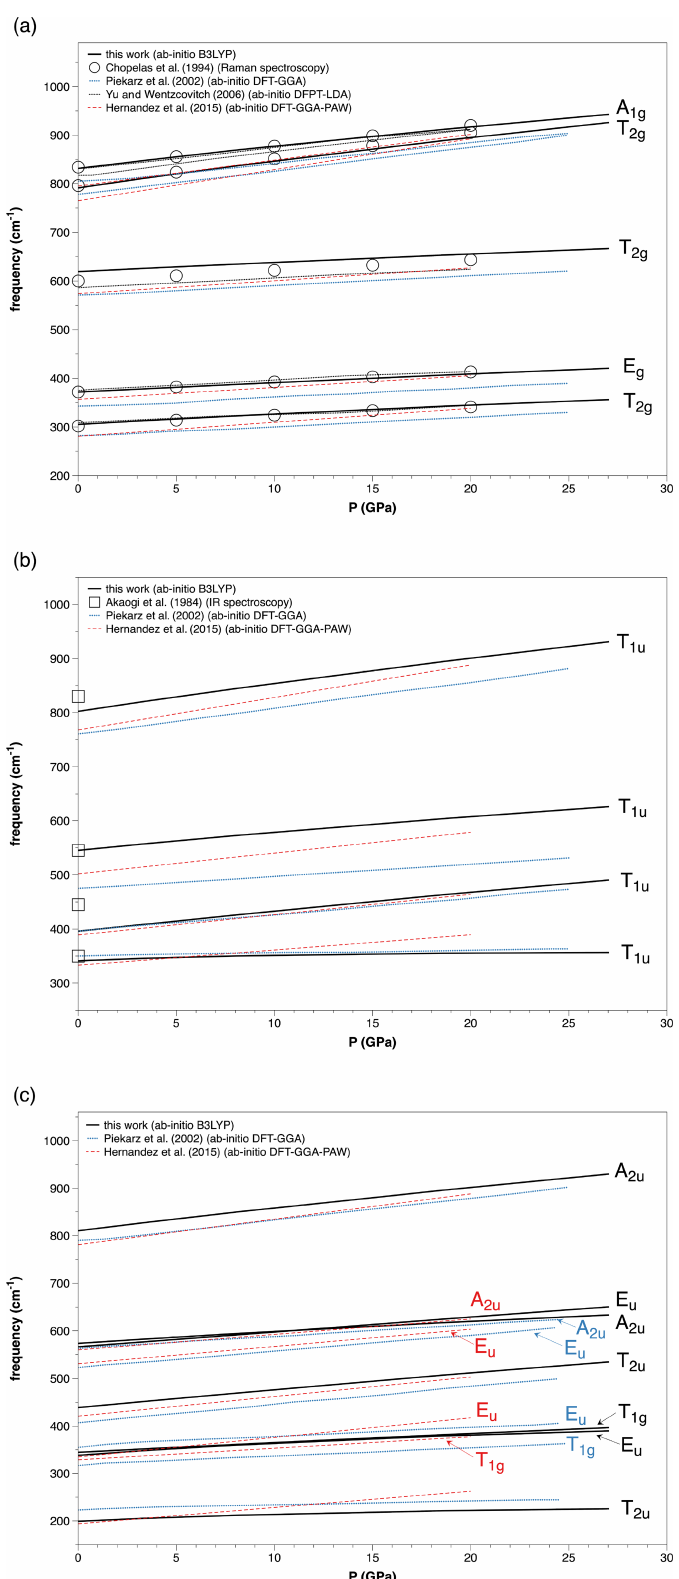
Figure 1. Pressure dependence of vibrational frequencies of Mg 2 SiO 4 ringwoodite. (a) Raman-active modes, (b) IR-active modes and (c) silent